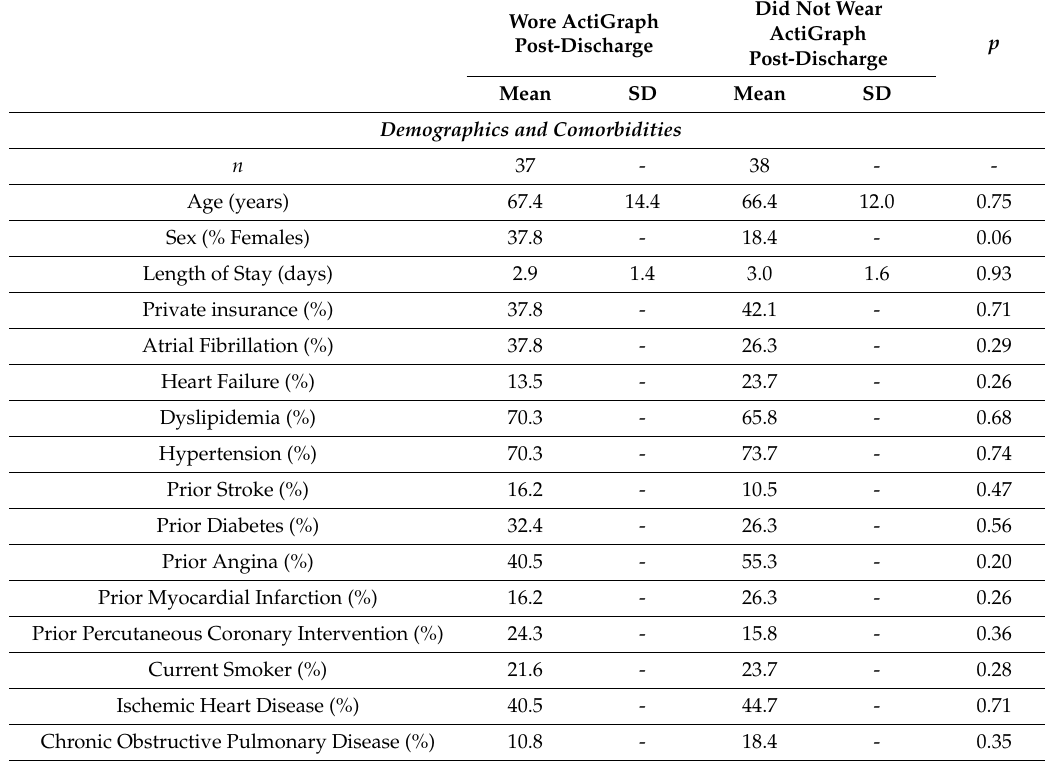
Table A6. Patient characteristic comparison of those who continued and to wear the ActiGraph post-discharge and those who did not.